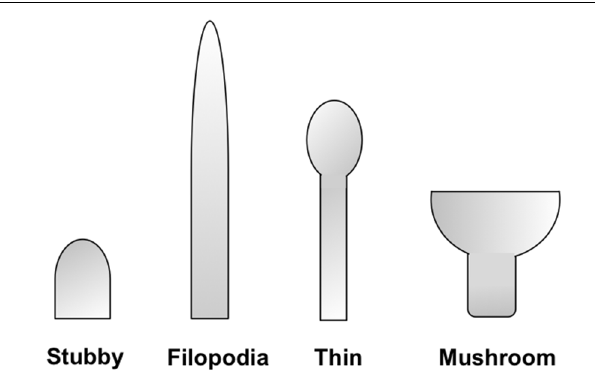
FIGURE 1 | Schematic representation of spine morphologies. Spines display a wide diversity of morphologies.They are commonly classified into four different categories (as illustrated from left to right): stubby, filopodia, thin, and mushroom-shaped. Stubby spines are devoid of a neck and are particularly prominent during postnatal development.Thin spines are most common and have a thin, long neck and a small bulbous head, whereas mushroom spines are those with a large head. Lastly, dendritic filopodia are typically longer, normally have no clear head, and often represent immature spines.